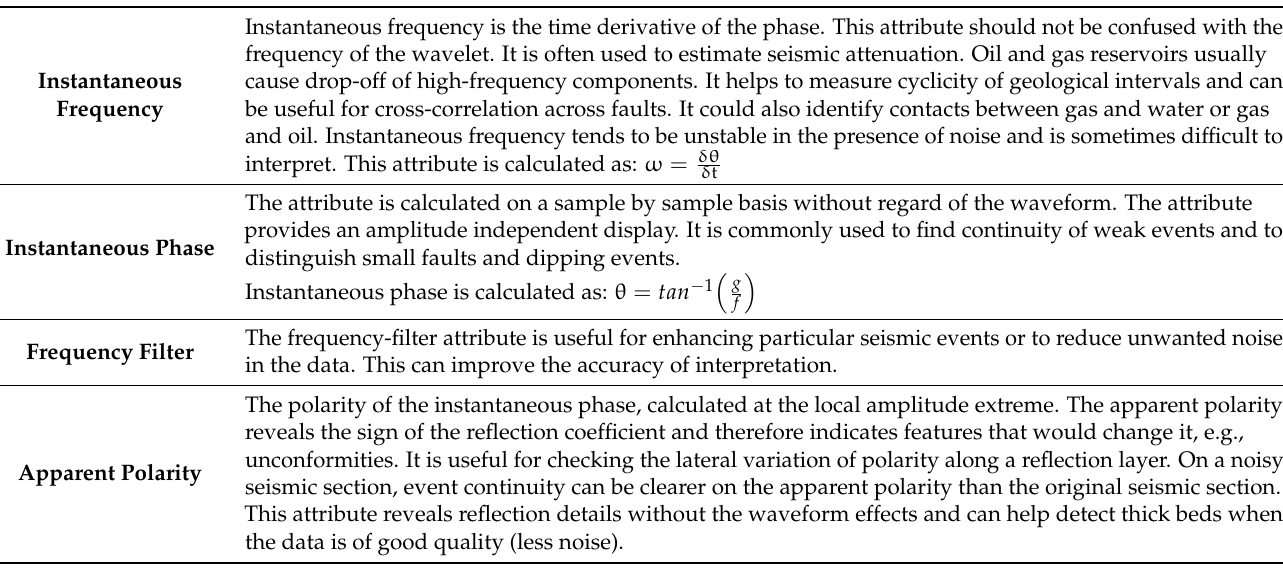
Table 2. A brief explanation of the most important seismic attributes employed in the current study [50].